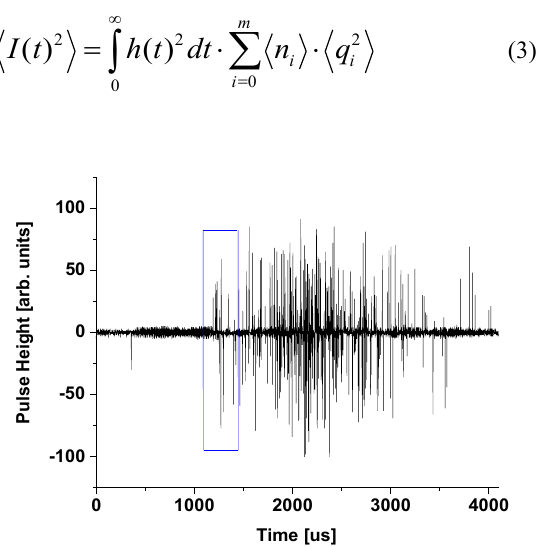
Fig. 3. Resulted waveform after second waveform was subtracted from the first one.